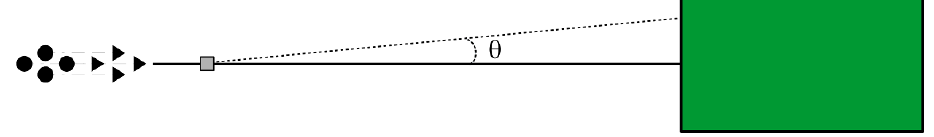
Figure 2. Production and detection of dark matter at a beam-dump experiment: a sketch of the setup and the kinematics.